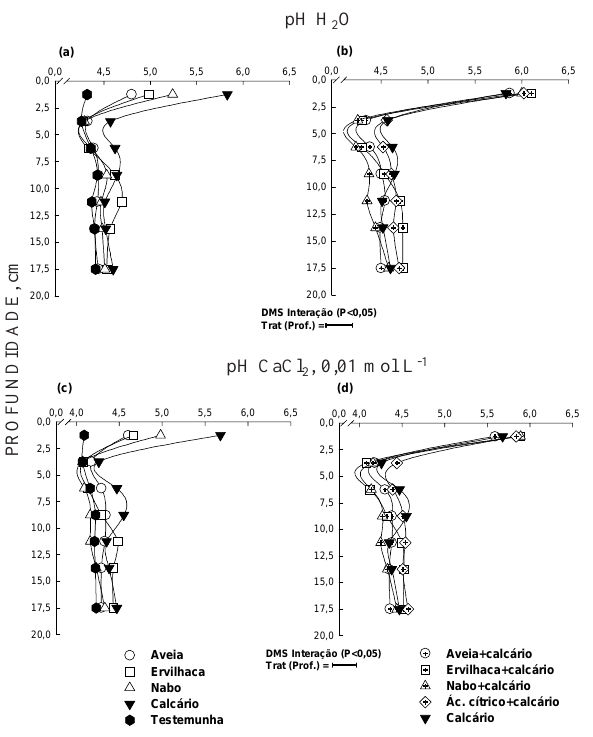
Figura 1. Valores dos atributos químicos no perfil do solo após 60 dias da aplicação superficial dos resíduos, isolados e junto com calcário, em colunas indeformadas, coletadas em área de plantio direto: pH em água (a) e (b) e pH em CaCl 0,01 mol L -1 (c) e (d). 2